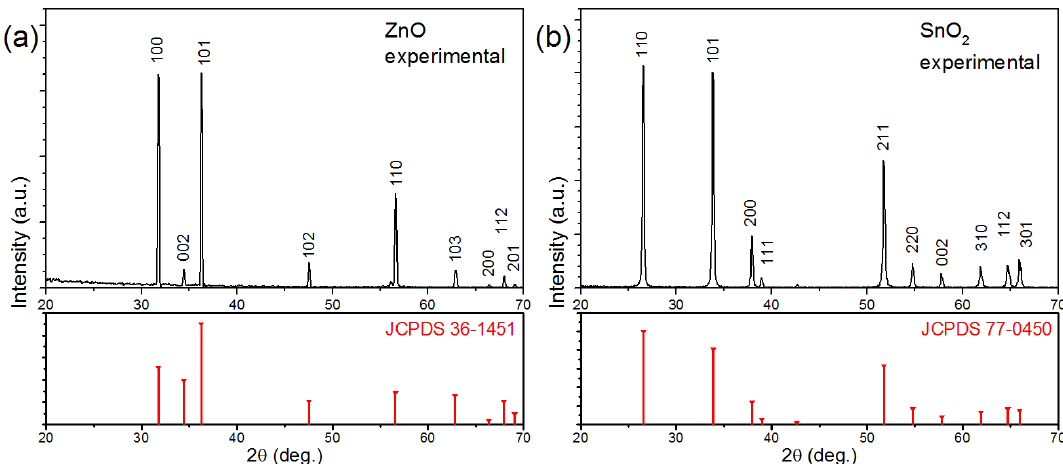
Figure 2. XRD patterns of the nanowires grown by CVD: ( a ) ZnO nanowires and ( b ) SnO 2 nanowires. The top images show the experimental patterns (in black), while the bottom images show the reference pattern from ICDD (in red).